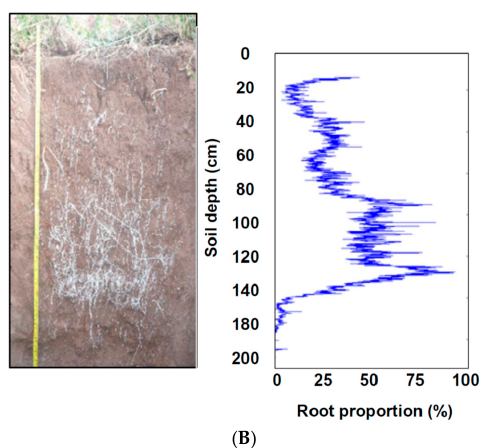
Figure 4. Different rooting patterns of alfalfa under: ( A ) sub-surface drip irrigation; and ( B ) surface irrigation. (Source: Courtesy of UC Desert Research and Extension Center, Holtville, CA, 2015).